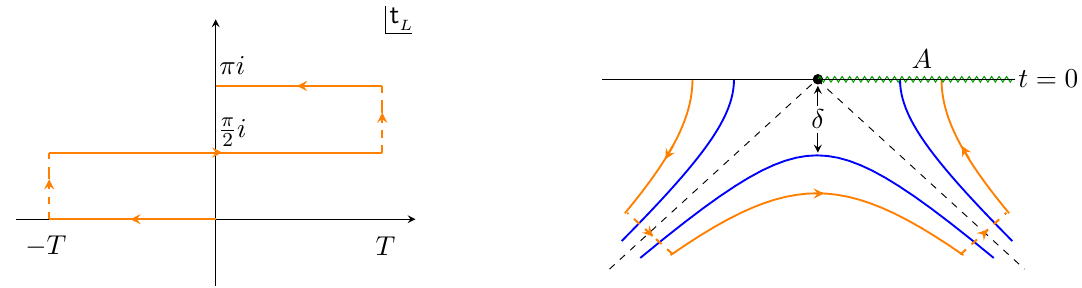
-plane. Right: boundary spacetime R 1 , 1 for L contour (orange) has an excursion into L